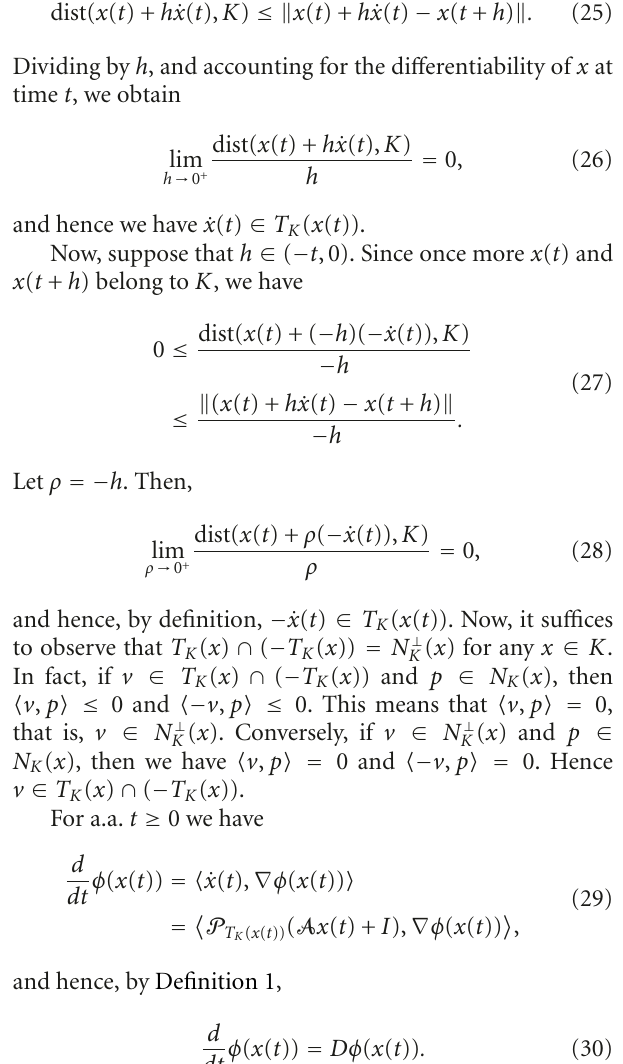
( x ) and f ( x ) / ∈ N ⊥ K K ( x )